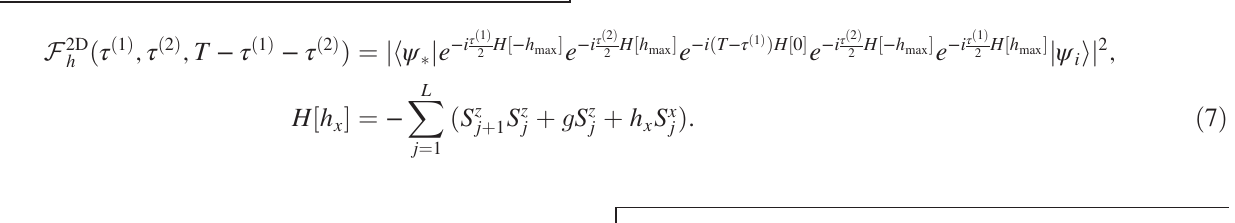
FIG. 5. (a) Three-pulse variational protocol which allows us to capture the optimal protocol found by the computer in the overconstrained phase but fails the glassy phase of the nonintegrable many-body problem. This ansatz captures the nonanalytic point at ≈ 0 . 4 but fails in the glassy phase. (b) The pulse durations τ ð 1 Þ T c length T of the type shown in (a). The fidelity of the variational protocols exhibits a physical nonanalyticity at T kinks outside the validity of the ansatz. (c) 1D maximal variational fidelity (dashed back) compared to the best numerical protocol (solid blue). (d) Five-pulse variational protocol which allows us to capture the optimal protocol found by the computer in the overconstrained phase and parts of the glassy phase of the nonintegrable many-body problem. (e) The pulse durations τ ð the best variational protocol of length T of the type shown in (d). These variational protocols exhibit physical nonanalyticities at T and T 0 ≈ 2 . 5 (vertical dashed lines) (f) 2D maximal variational fidelity (dashed-dotted back) compared to the best numerical protocol (solid